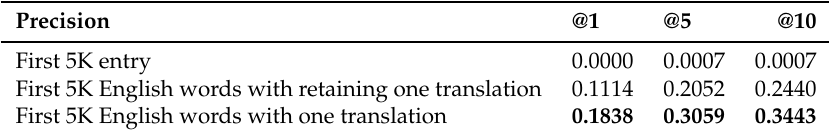
Table 6. Italian–English precision values with the different training sets.